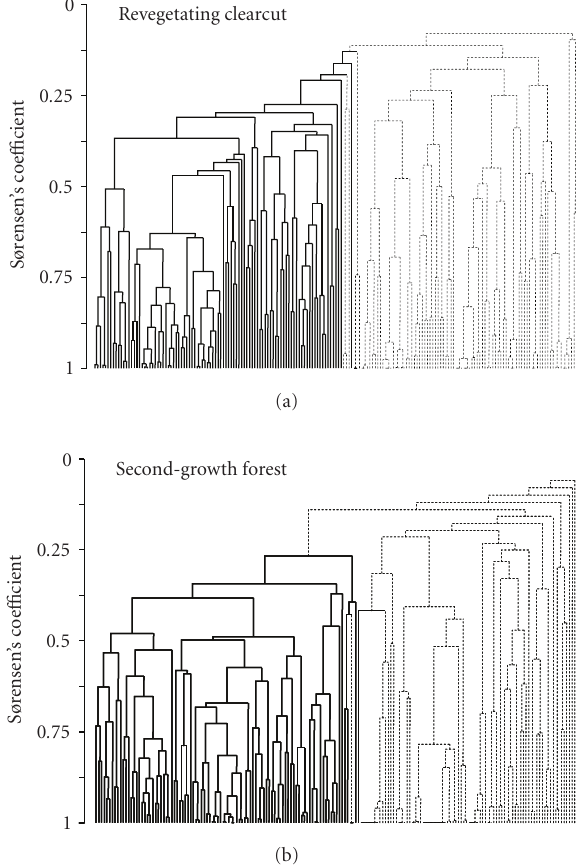
Figure 2: Dendrogram representing UPGMA cluster analysis of aboveground (broken) and seed bank (solid) samples in revegetat- ing clearcut and second-growth forest quadrats at